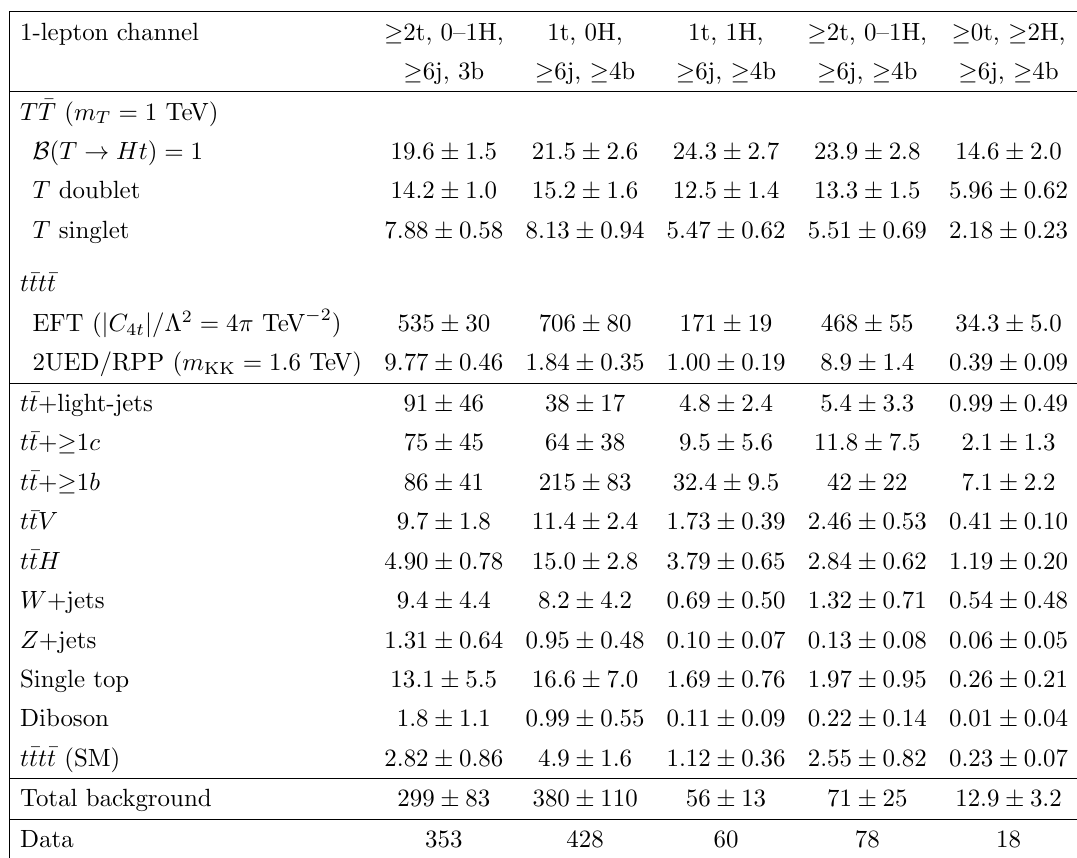
Table 4. Predicted and observed yields in the 1-lepton channel in (cid:12)ve of the most sensitive search regions (depending on the signal scenario) considered. The multijet background is estimated to be negligible in these regions and thus not shown. The background prediction is shown before the (cid:12)t to data. Also shown are the signal predictions for di(cid:11)erent benchmark scenarios considered. The quoted uncertainties are the sum in quadrature of statistical and systematic uncertainties in the yields, excluding the normalisation uncertainty of the t (cid:22) t + 1 b background, which is determined (cid:21) via a likelihood (cid:12)t to